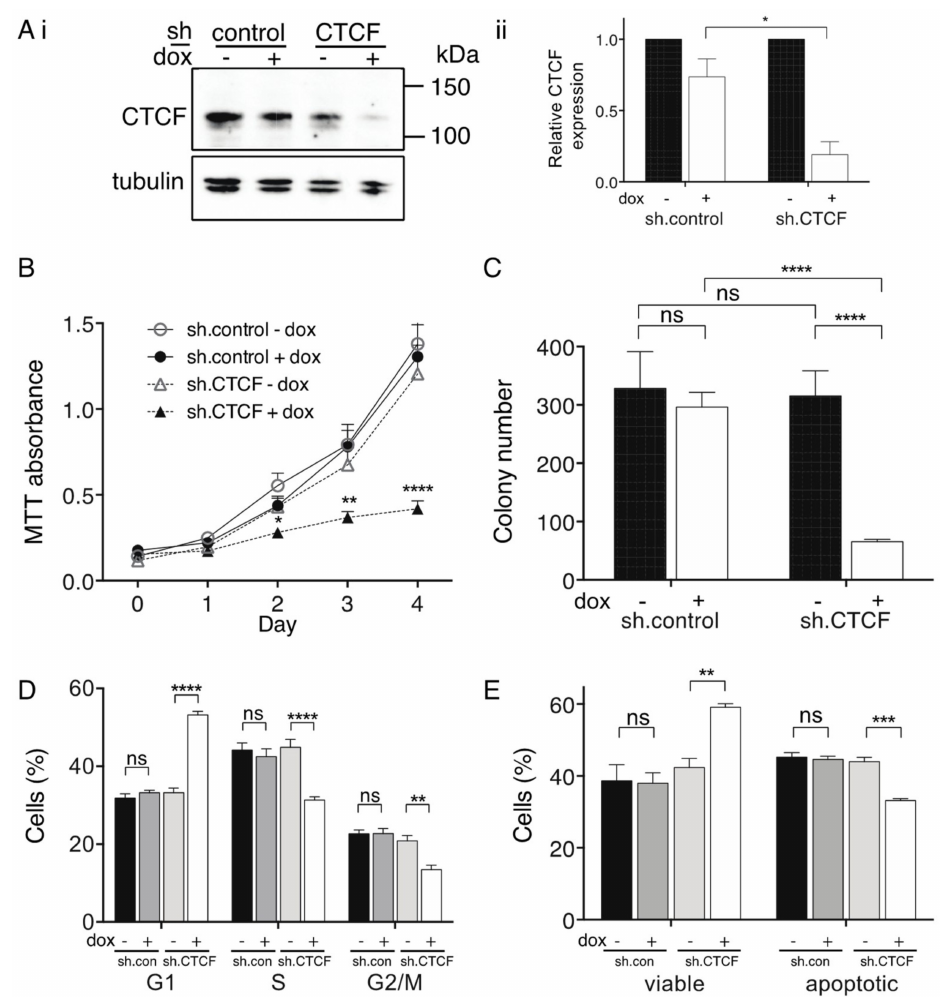
Figure 1. Inhibition of cell proliferation and clonogenicity following CTCF shRNA knockdown in K562 cells. ( A ) Immunoblot of CTCF shRNA knockdown in the presence and absence of doxycycline (dox) compared to control shRNA after 4 d: representative immunoblot ( i ); and relative CTCF expression normalised to α -tubulin confirmed by ImageJ densitometric analysis ( ii ). Functional assays